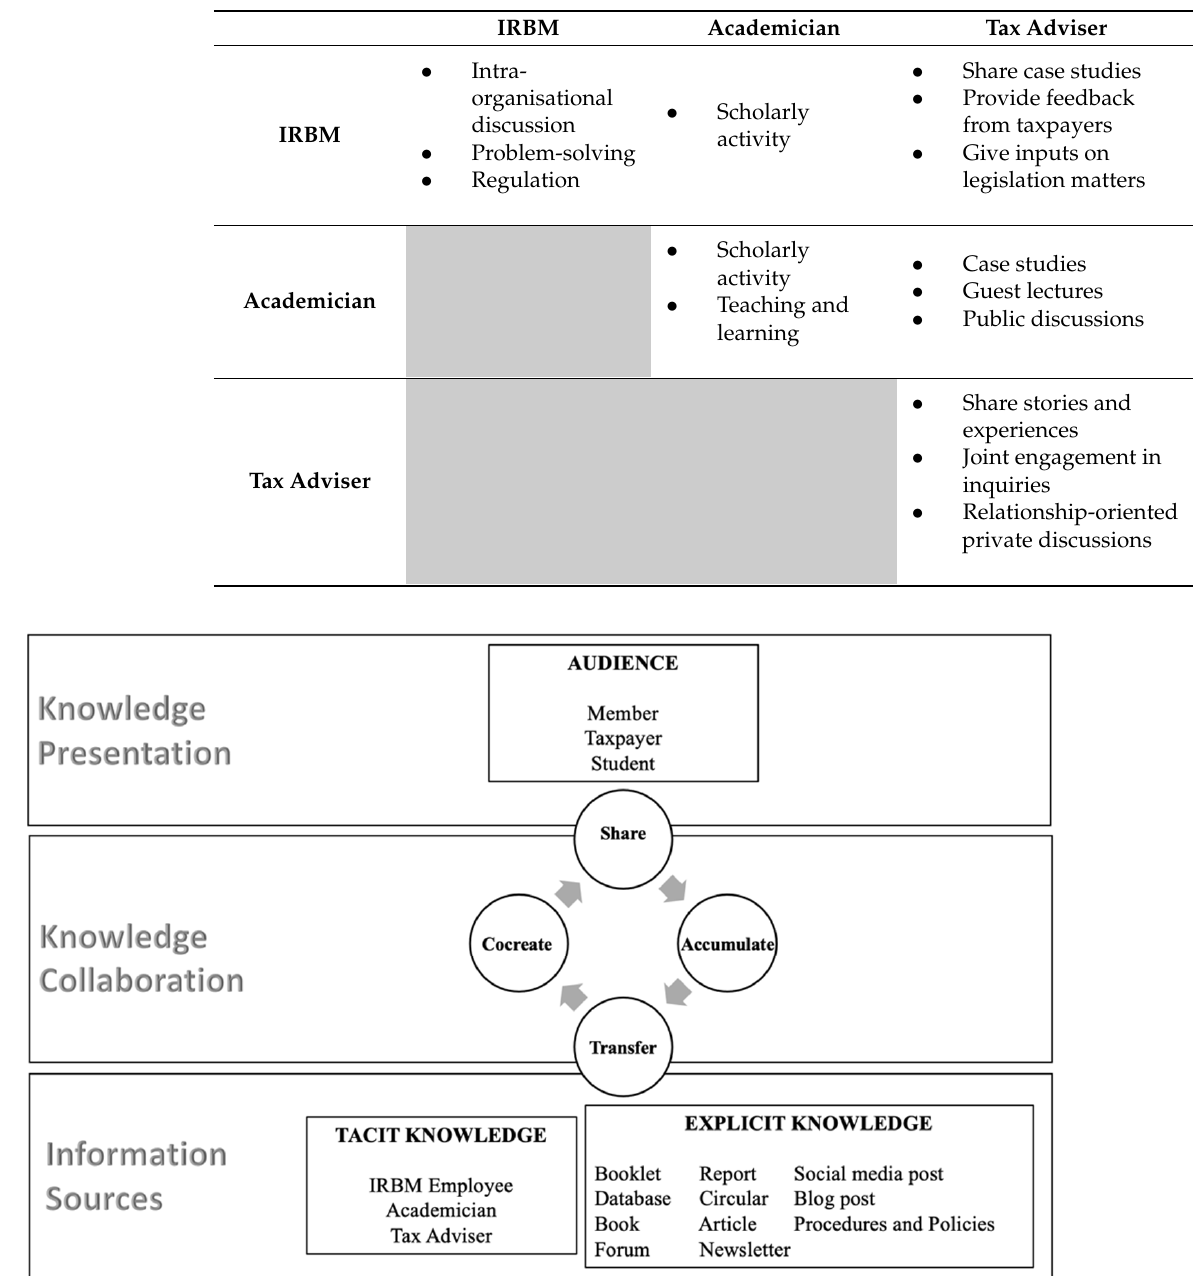
Table 4. Common collaboration activities among the entities.